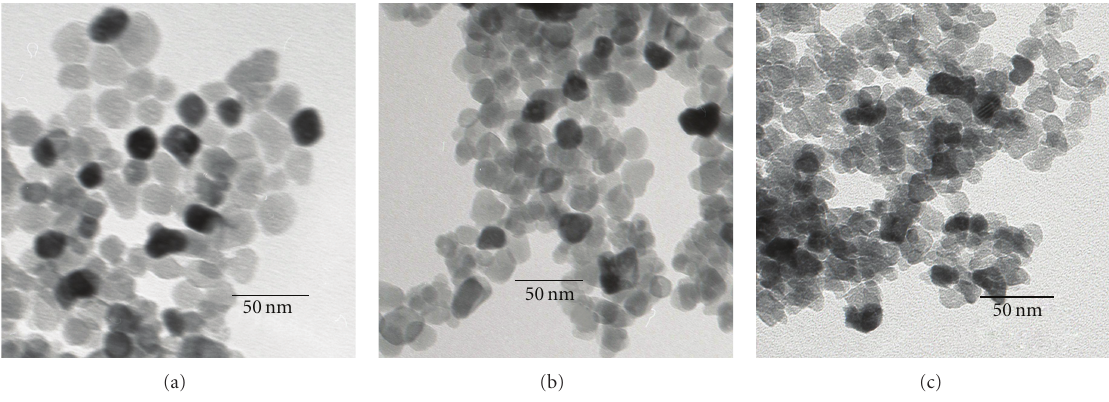
Figure 5: TEM images of SrTi 1 − x Ta x O 3 − y N y , (a) x = 0, (b) x = 0 . 05, and (c) x = 0 . 1.